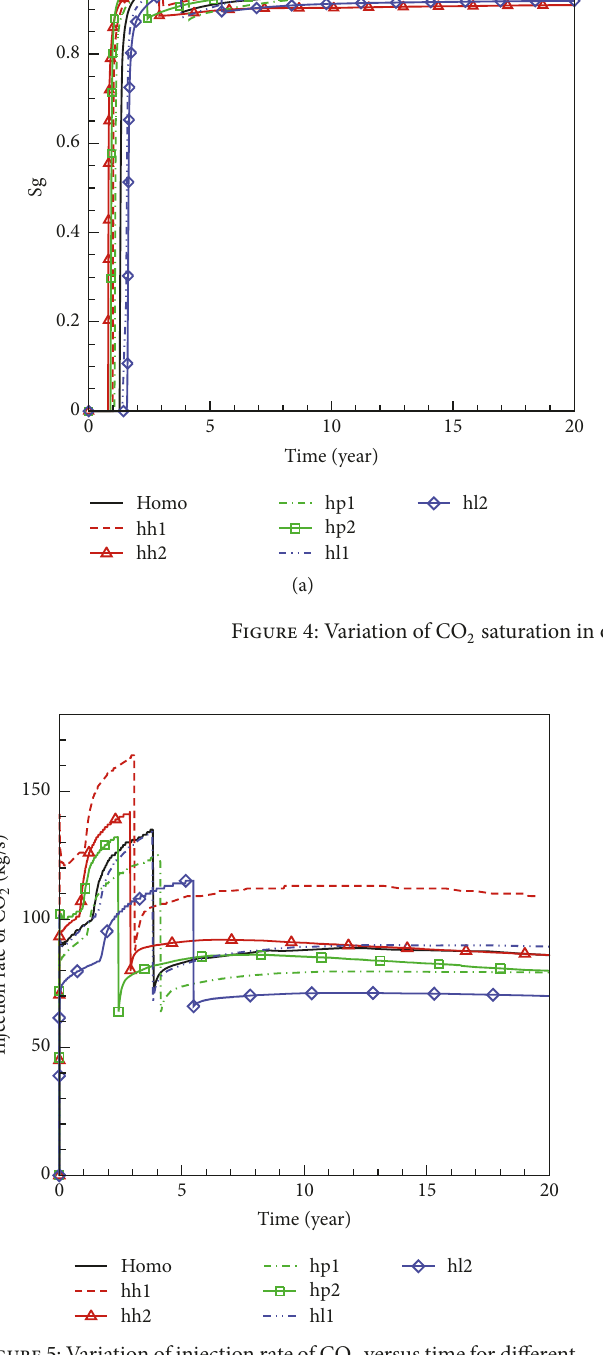
Figure 5: Variation of injection rate of CO 2 versus time for different